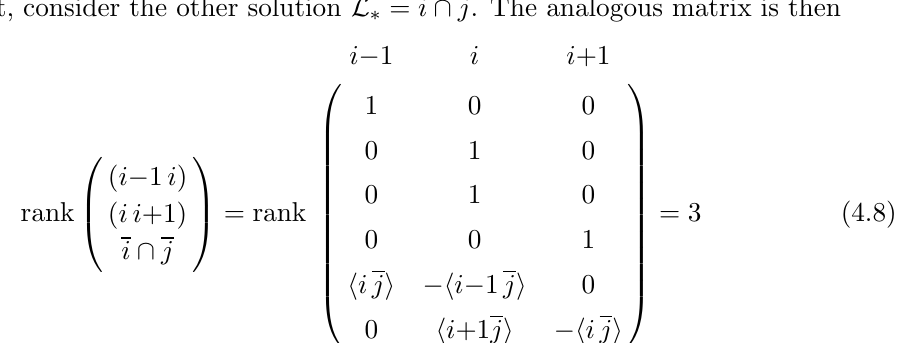
Table 6 . Two colorings of the two-mass easy box. Row (a) shows the MHV coloring and momentum twistor solution to the on-shell conditions, and row (b) shows the same for the N 2 MHV solution. In contrast, consider the other solution